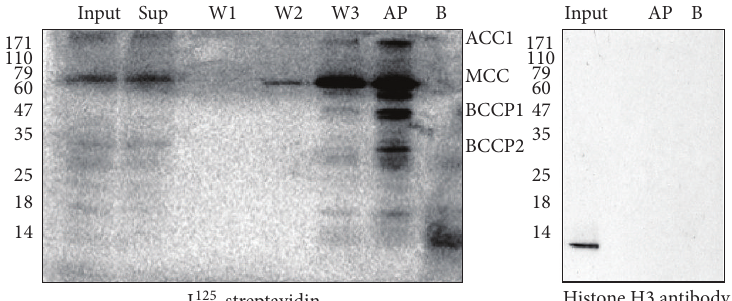
Figure 3: Avidin precipitation assays. The protein samples were analyzed by 15% SDS-PAGE. I 125 -streptavidin (left panel) and histone H3 antibody (right panel) were used in the western blots. Input: total protein extracted from Arabidopsis . B: blank control, where avidin beads were used only with release buffer. Sup: the supernatant after the avidin beads were incubated with Arabidopsis lysate overnight. W1/2/3: the supernatants for the first, second, and third washes separately after the incubation. AP: precipitation of total protein preformed with avidin beads. ACC1: homomeric acetyl-CoA carboxylase. MCC: methylcrotonyl-CoA carboxylase. BCCP1: biotin carboxyl carrier protein1, which is part of the heteromeric acetyl-CoA carboxylase. BCCP2: biotin carboxyl carrier protein2, which is part of the heteromeric